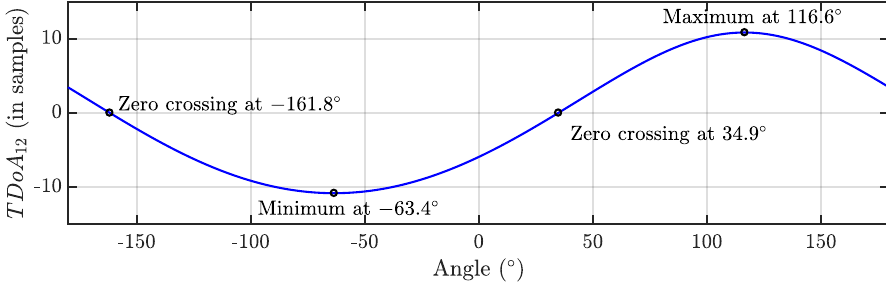
Figure 2. Periodic function representing the TDOA vs the rotating angle. The units in the TDOA are samples because it is easier to study the sensibility of the